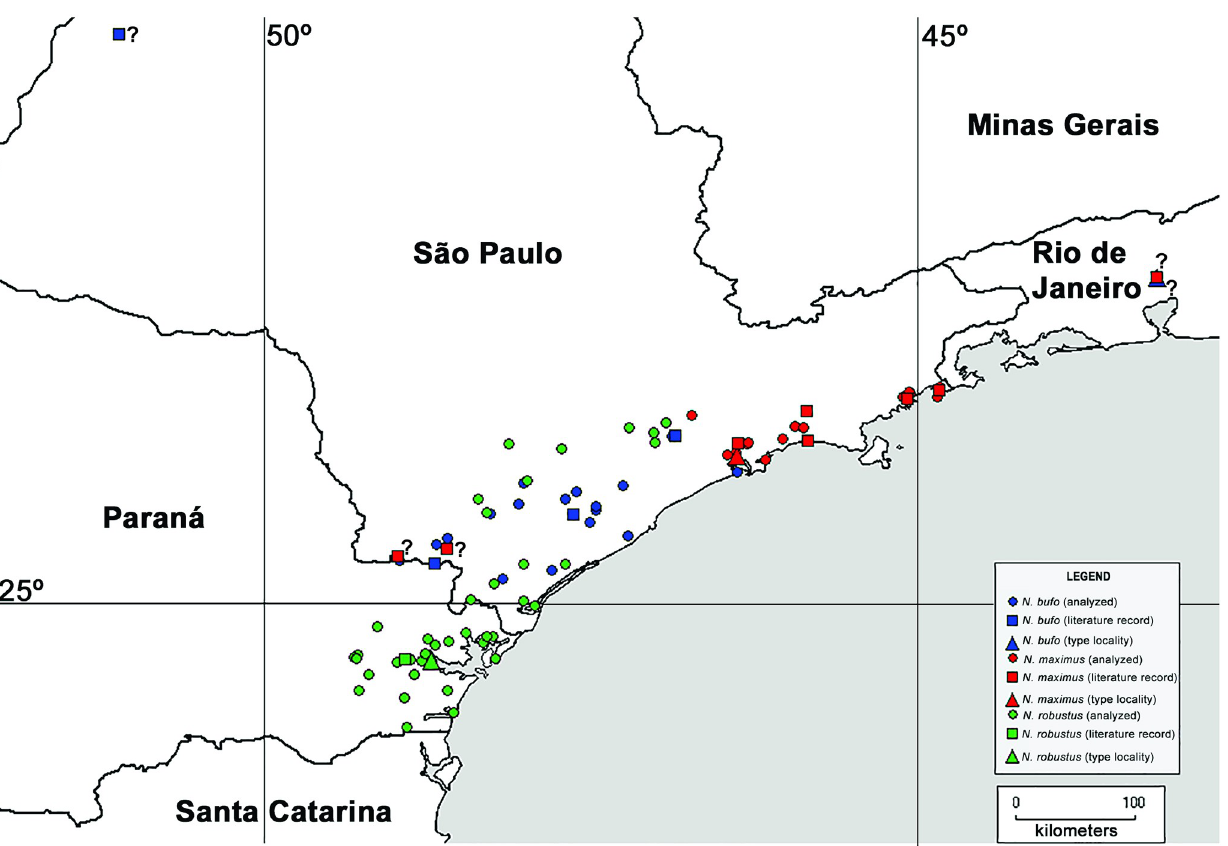
Fig 2. Distribution of Neosadocus species. The map indicates localities of specimens collected and used in our morphological and molecular analyses, and locality data of type material and literature records of collection sites. Question marks (?): doubtful records. Map elaborated with free, public shapefiles available on DIVA-GIS software website